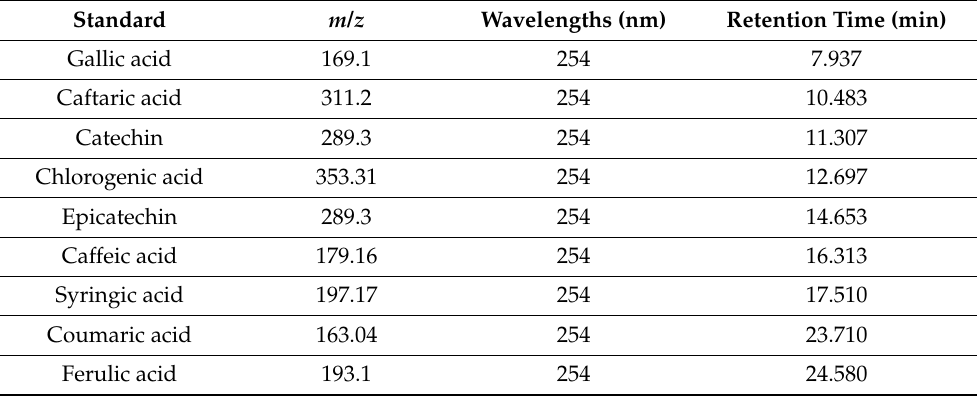
Table 2. Wavelengths of quantification, mass to charge ( m / z ) ratios and retention times related to the investigated phenolic